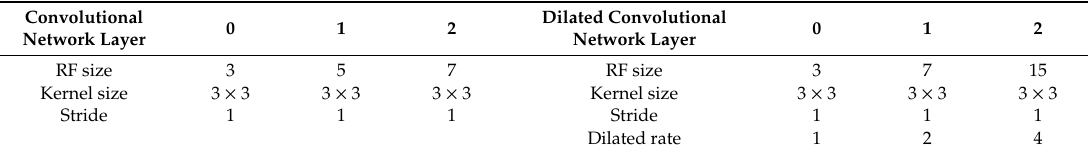
Table 2. Comparison of receptive fields, kernel sizes, and strides between convolutional network and dilated convolutional network of each layer.